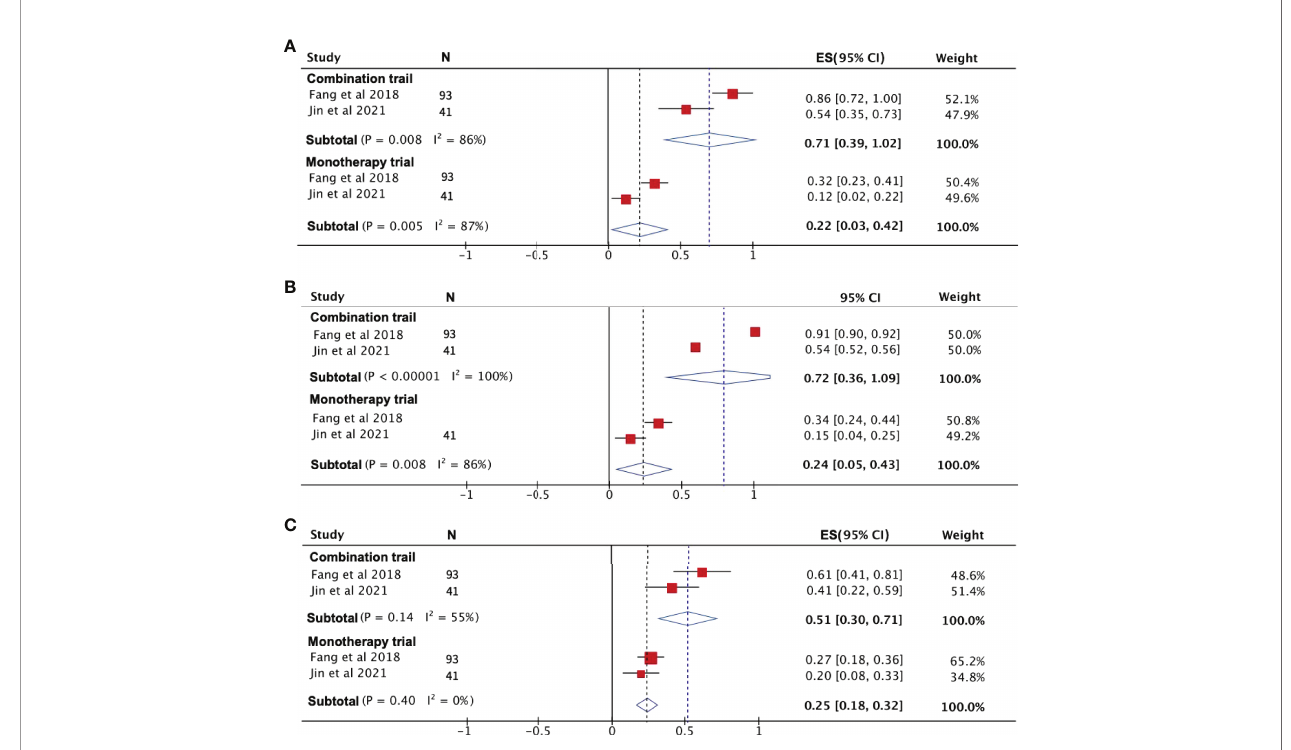
FIGURE 6 | The ef fi cacy of PD-1 treatment with or without chemotherapy. (A) Partial response rate. (B) Objective response rate. (C) Progression-free survival